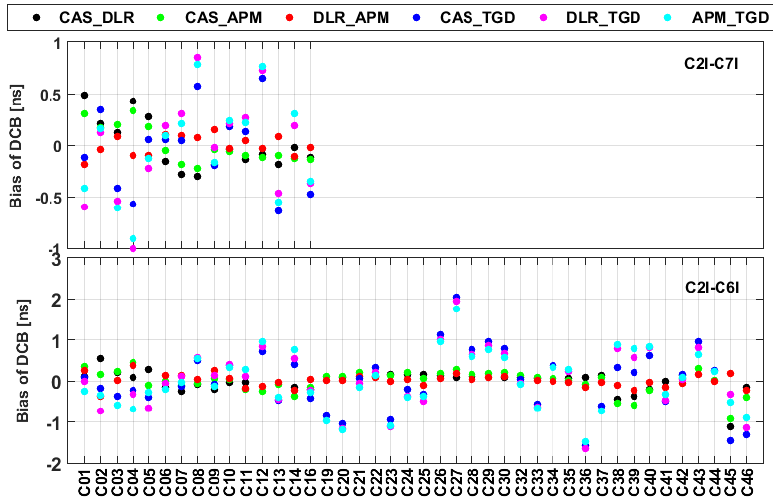
Figure 6. RMS time series of the differences in BDS-based C2I-C6I and C2I-C7I DCB estimates between different solutions during the period of DOY 091–103 in 2020.